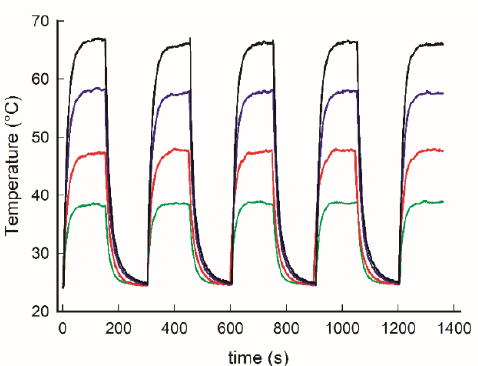
Figure 4. Thermograms for PDMS samples with increasing concentrations of embedded GNS (green: 0.9 × 10 − 6 mol Au/g of elastomer; red: 1.8 × 10 − 6 ; blue 2.7 × 10 − 6 ; black 3.6 × 10 − 6 ) on alternating 150 s irradiation ON with 150 s